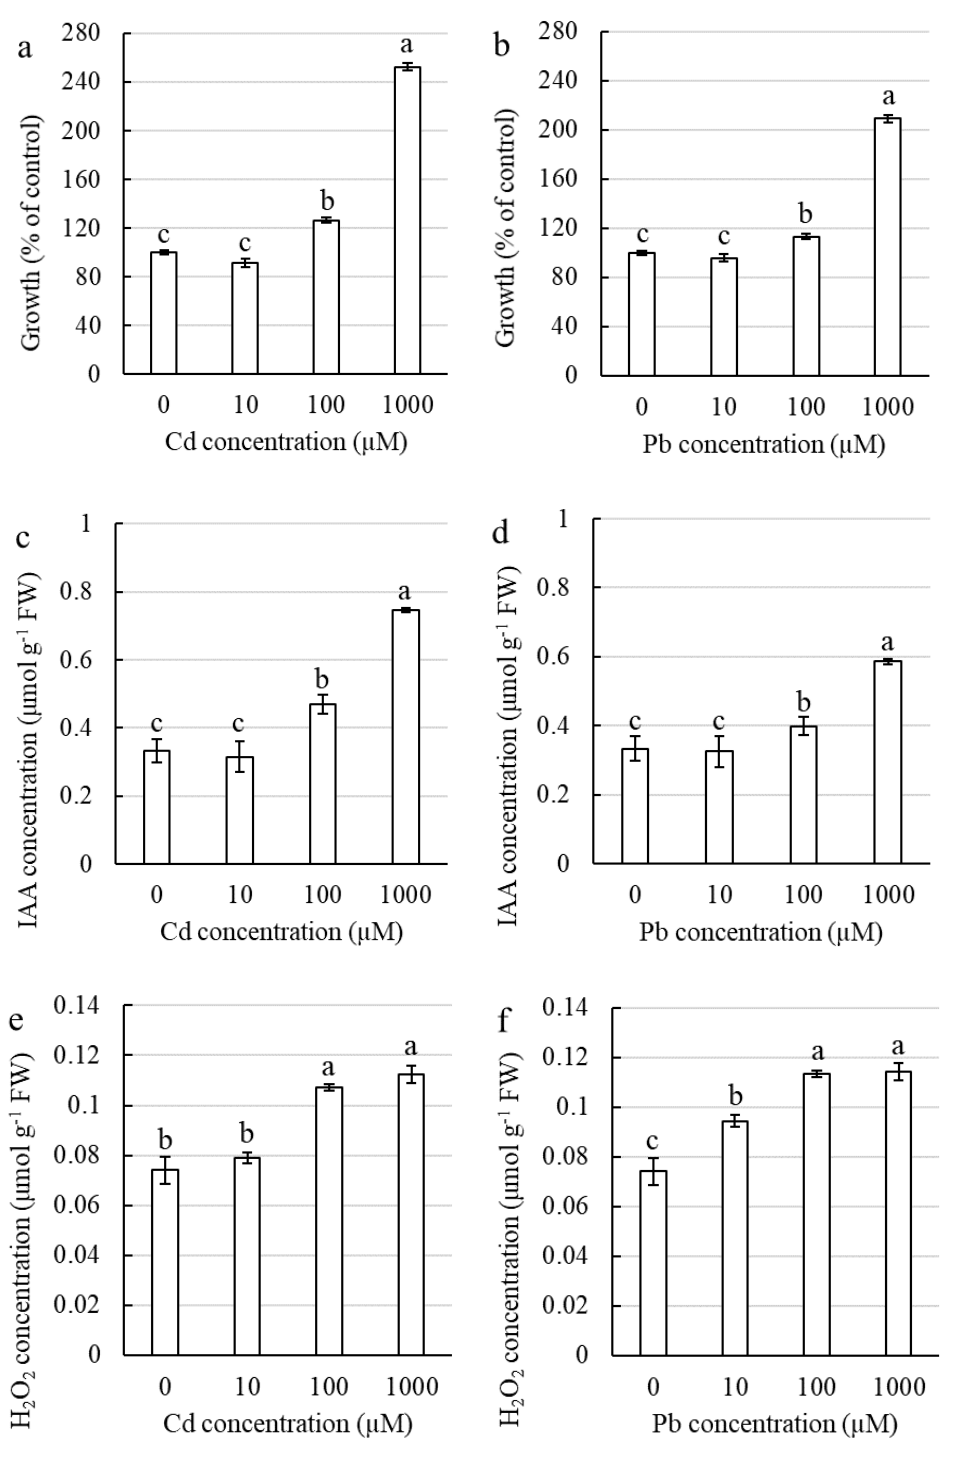
Figure 1. Physiological characteristics of the corn coleoptile sections that had been excised from the seedlings that had been treated with Cd or Pb for 24 h. The growth of sections was measured after incubation in APW for 24 h—( a ) Cd and ( b ) Pb; concentration of IAA—( c ) Cd and ( d ) Pb; concentration of H 2 O 2 —( e ) Cd and ( f ) Pb. The values are the means ± SE ( n = 3). Means followed by the same letter are not significantly different from each other using the LSD test ( p < 0.05).